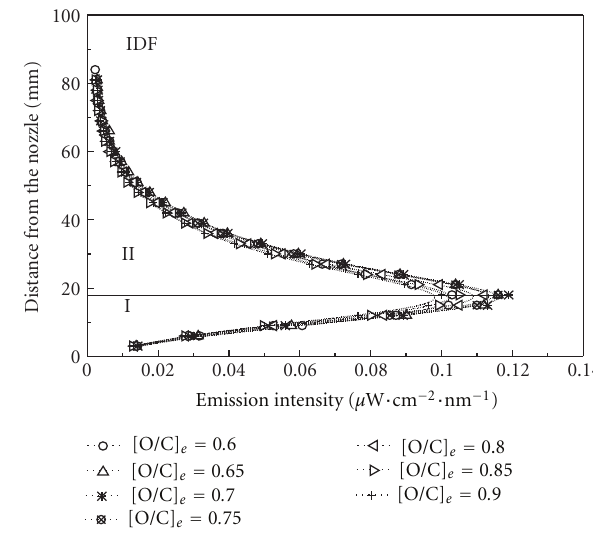
distribution with increasing ∗